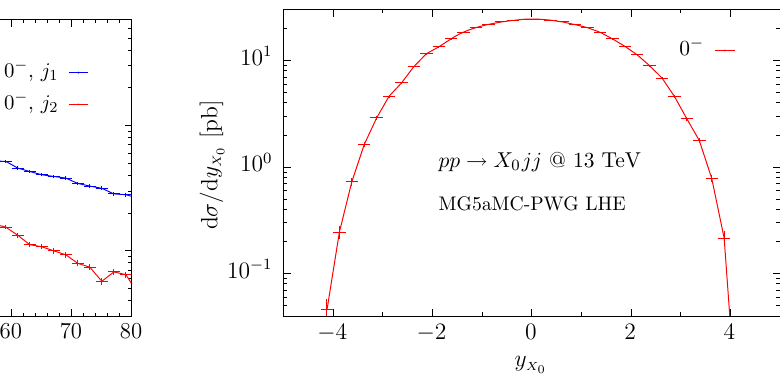
Fig. 13 On the left panel the inclusive differential cross section as a function of the transverse momentum of the hardest jet, in blue, and of the second-to-hardest one, in red. The CP scenario is defined by